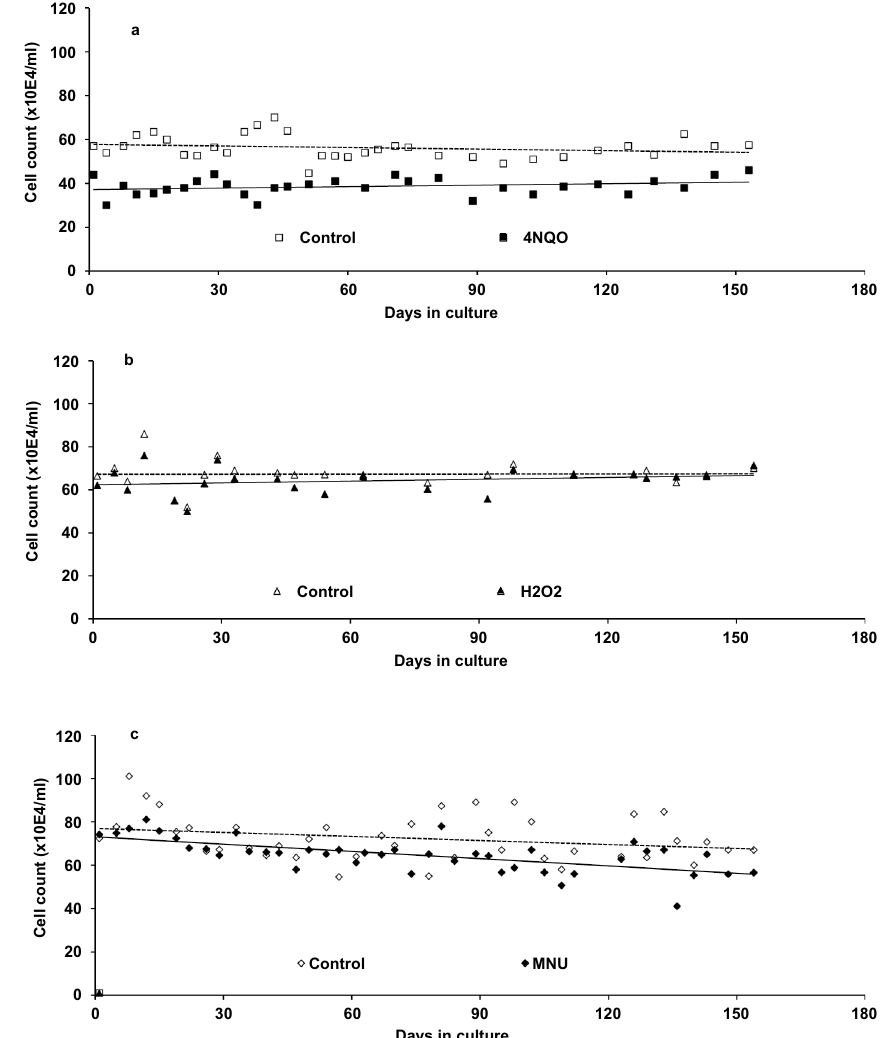
Figure 4. GM1899A cell counts over a six-month period in the absence or presence of 20 ng/ml 4NQO ( a) , 10 μM